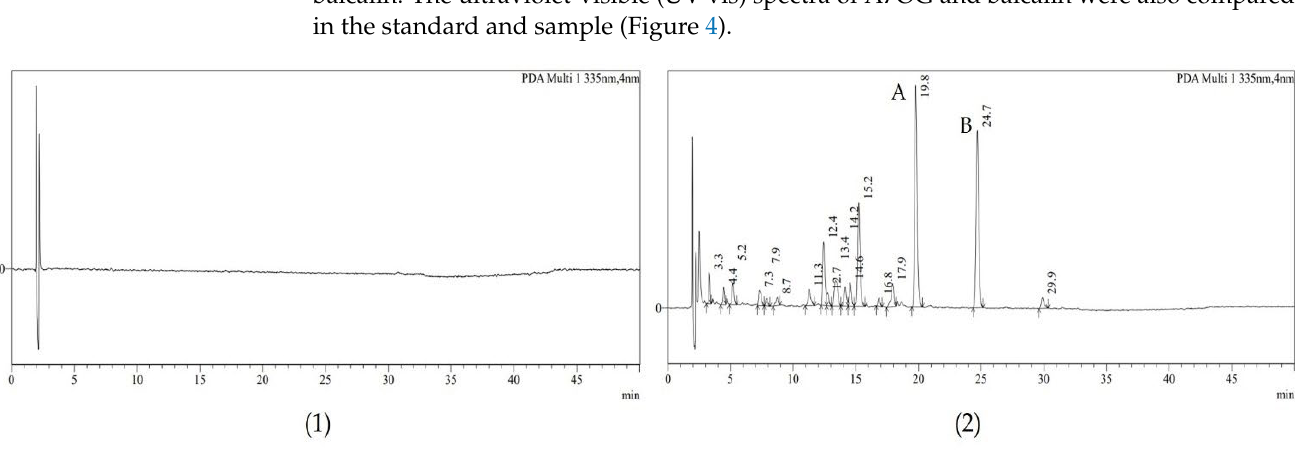
Figure 3. HPLC-DAD chromatogram of the ( 1 ) blank matrix cream; ( 2 ) 0.1% AE cream pretreated solution with internal standard. Peak A represents A7OG, and peak B represents baicalin, which is the internal standard.